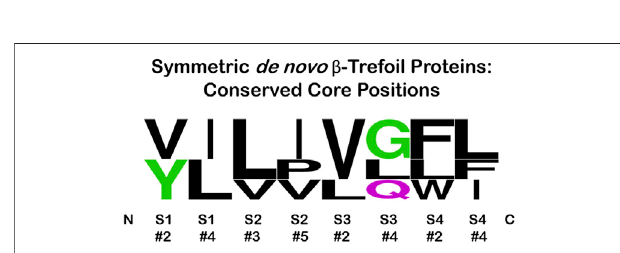
FIGURE 8 | Sequence logo plot of the set of symmetric core-packing residues (see Figure 6 ) present in de novo designed symmetric β -trefoil proteins Symfoil-4T (3O4B), Phifoil (4OW4), Threefoil (3PG0), and Misuba-1 (5XG5).Thepositionswithinasingletrefoilmotifareshown,buttheseare replicated exactly for the other two trefoil motifs in each protein. Position #4 in S1, and position #3 in S2, have the highest neighbor contacts among the set of core residues (Blaber,